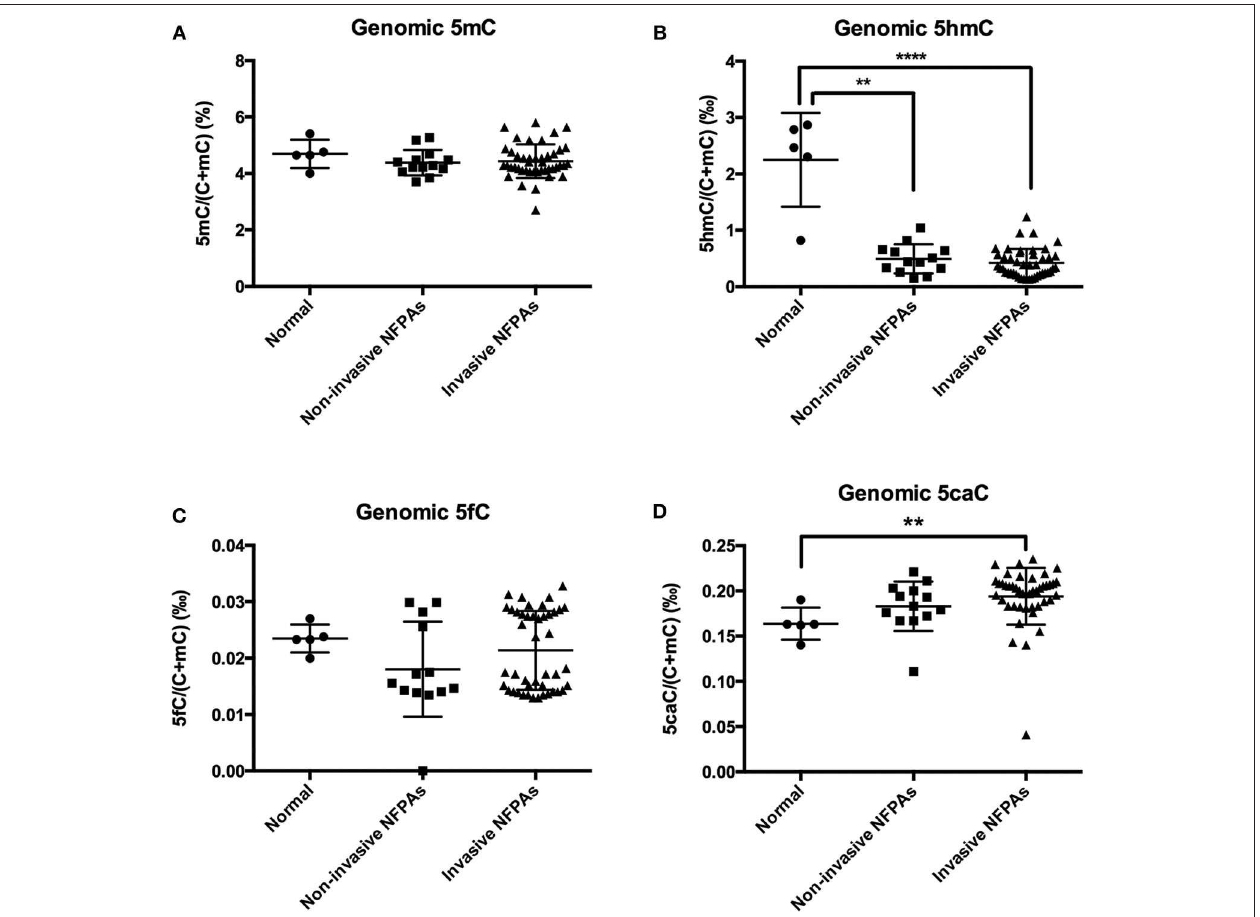
FIGURE 2 | Genomic 5mC, 5hmC, 5fC, and 5caC levels in invasive NFPAs, non-invasive NFPAs and normal pituitary glands. (A) There was no significant difference in genomic 5mC among normal pituitary glands, non-invasive NFPAs and invasive NFPAs. (B) Genomic 5hmC levels in non-invasive and invasive NFPAs were significantly decreased compared with those in normal pituitary glands. But there was no significant difference in genomic 5hmC levels in non-invasive and invasive NFPAs. (C) There was no significant difference in genomic 5fC among normal pituitary glands, non-invasive NFPAs and invasive NFPAs. (D) Genomic 5caC levels in invasive NFPAs were significantly increased compared with those in normal pituitary glands. There was no significant difference in genomic 5caC levels in non-invasive NFPAs and normal pituitary glands. There was no significant difference of genomic 5caC levels in non-invasive and invasive NFPAs. ** P < 0.01; **** P < 0.0001